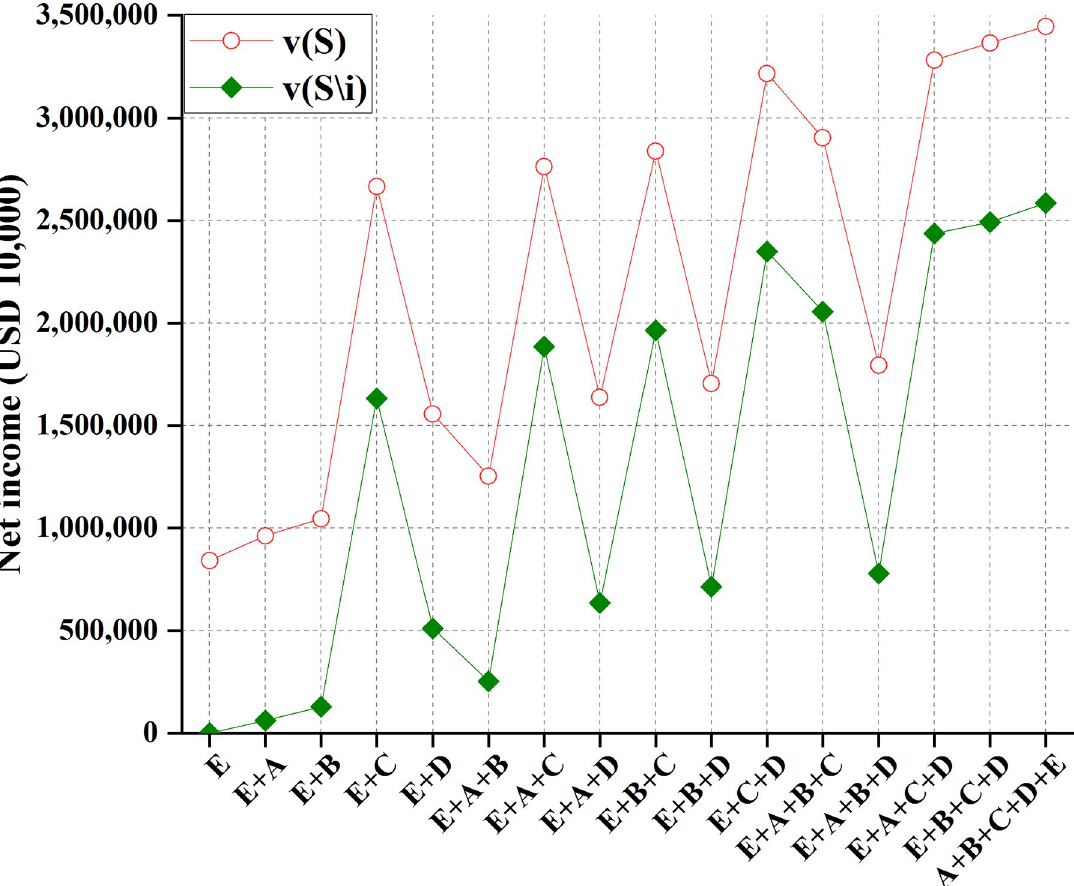
Fig 17. Profit comparison of 16 cooperation modes between Vietnam and other four countries.